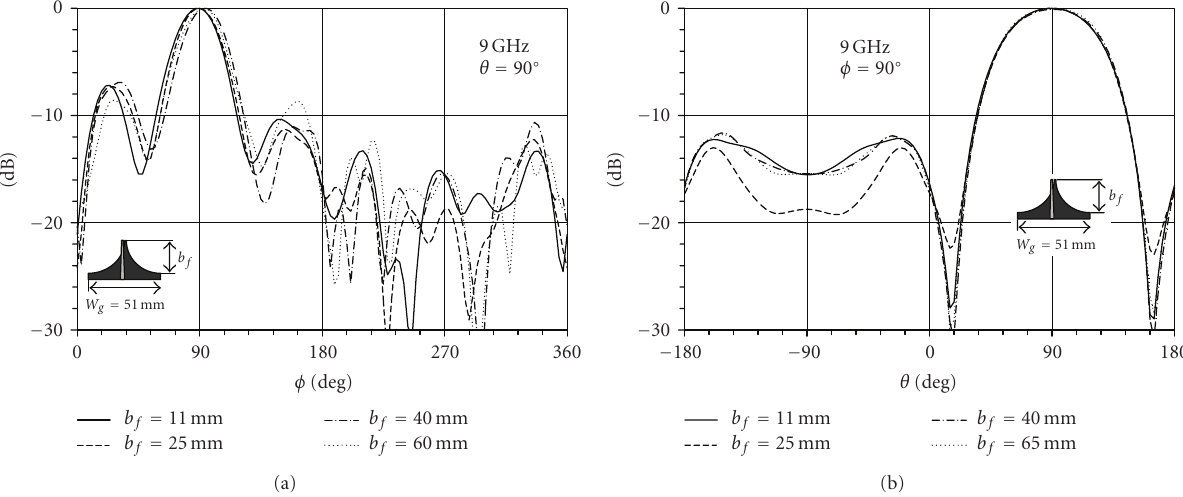
Figure 13: Current distribution for DETASAs with di ff erent profile of slotline radiator: (a) a 1 = 50 mm, a 2 = 20 mm, (b) a 1 = 30 mm, and a 2 = 20mm.